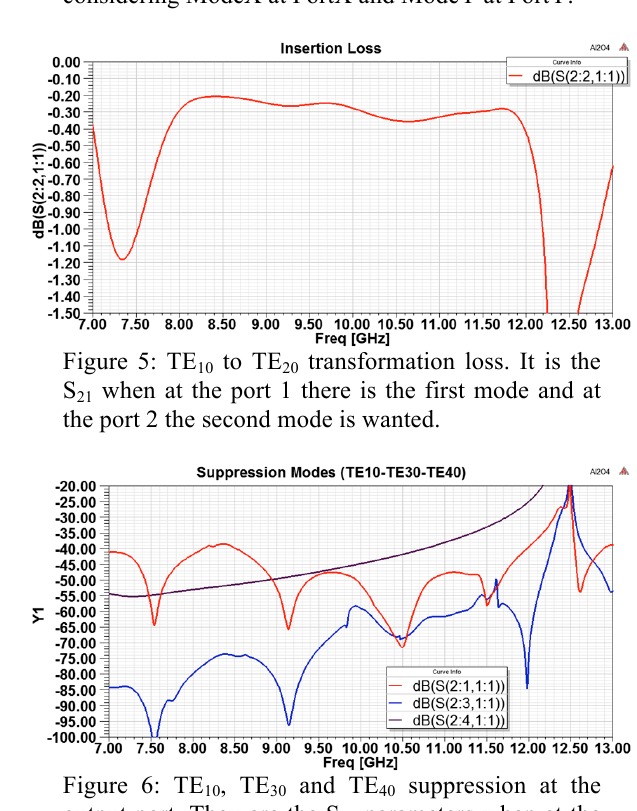
Figure 4: Return loss for the fundamental mode at the input port and for the first 4 modes at the output port (from TE to TE ). dB( S(PortX : ModeX, PortY : 10 40 ModeY) ) indicates the S(PortX,PortY) parameter considering ModeX at PortX and ModeY at PortY.